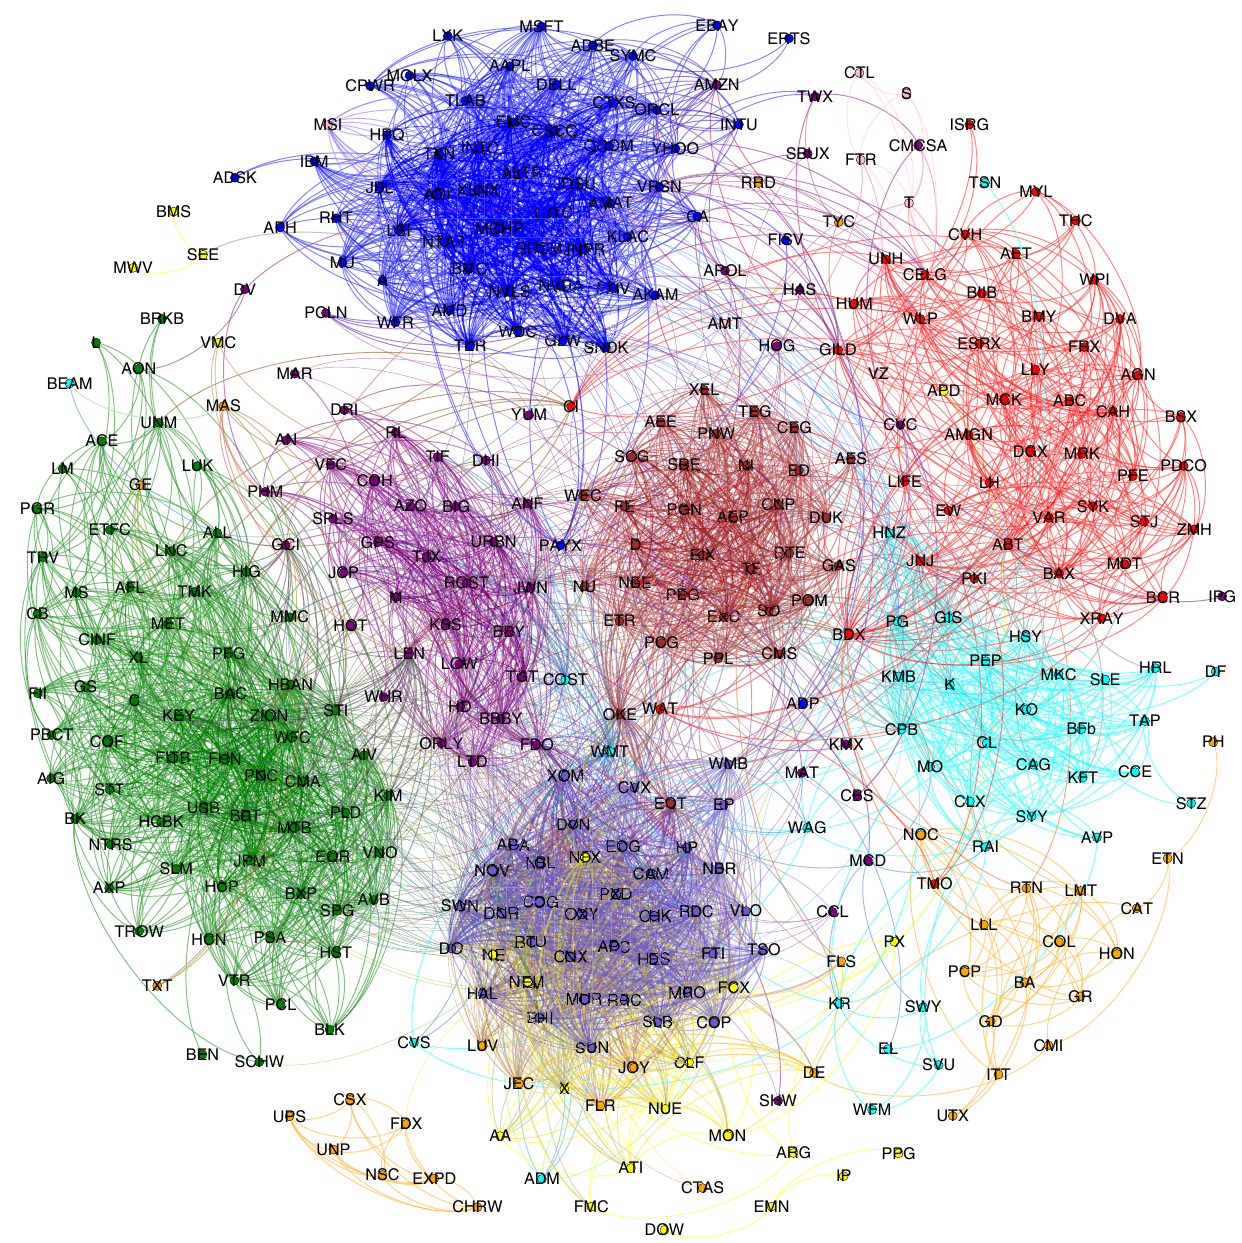
FIG. 5. Asset graph for the S&P 500 (log-returns of daily closing prices from 2001Q4 to 2011Q3). The network is generated from the correlation matrix of the constituent stocks, after taking the Fisher transform and setting a threshold at 2 standard deviations. The color of each node represents the industry sector to which that stock belongs (see Table I). The force-based layout clearly indicates the existence of strong connections between stocks of the same industry sector; however, this approach (like any other threshold-based approach) cannot identify communities of stocks that are internally more correlated than with the rest of the market, and mutually